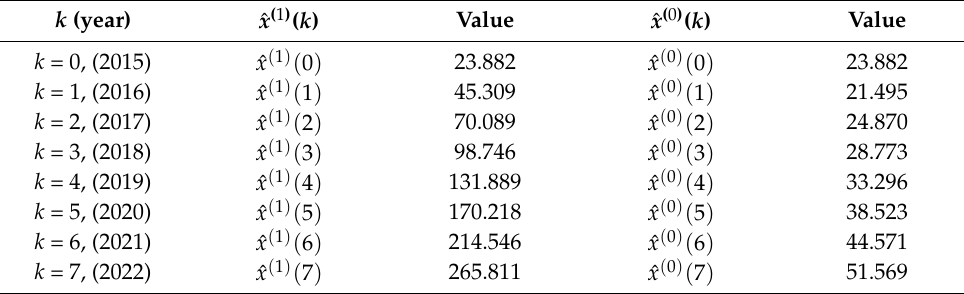
Table 4. Value of prediction of REC-12 (Tin Nghia)-Total assets (2019–2022).